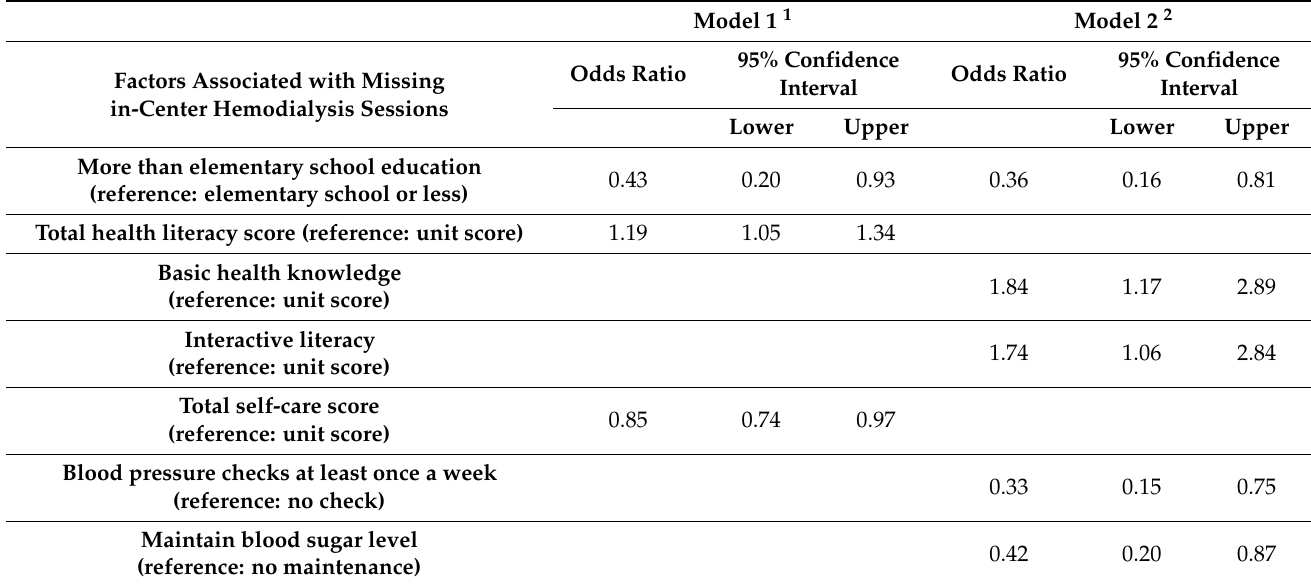
Table 5. Multivariable logistic regression models for factors associated with missing hemodialysis